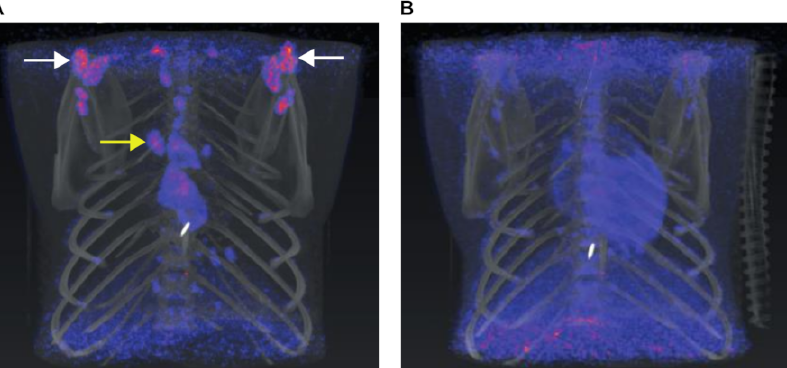
Figure 3. ( A ) Brown adipose tissue (BAT) activation is most prominent around the supraclavicular (white arrows) and paravertebral (yellow arrow) region. ( B ) The same animal scanned at another timepoint without BAT uptake. Similar window-level settings are applied to both scans.